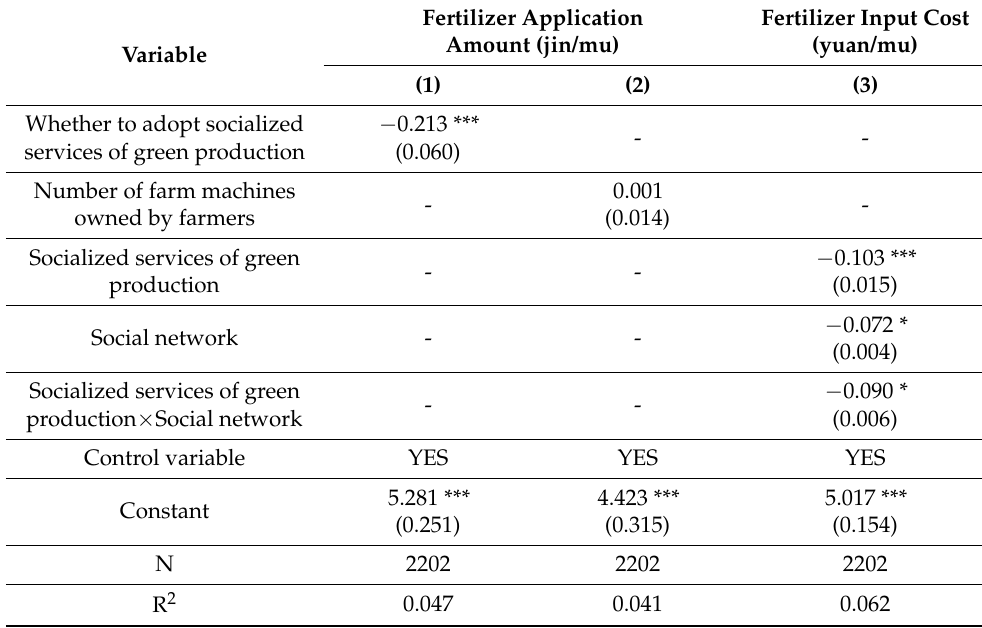
Fertilizer Input Cost (yuan/mu)